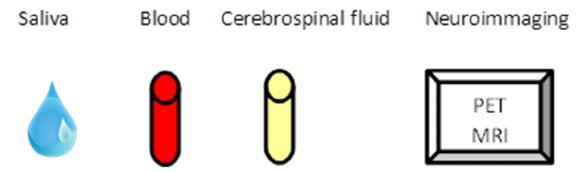
Figure 2. How measure potential biomarkers can be measured.